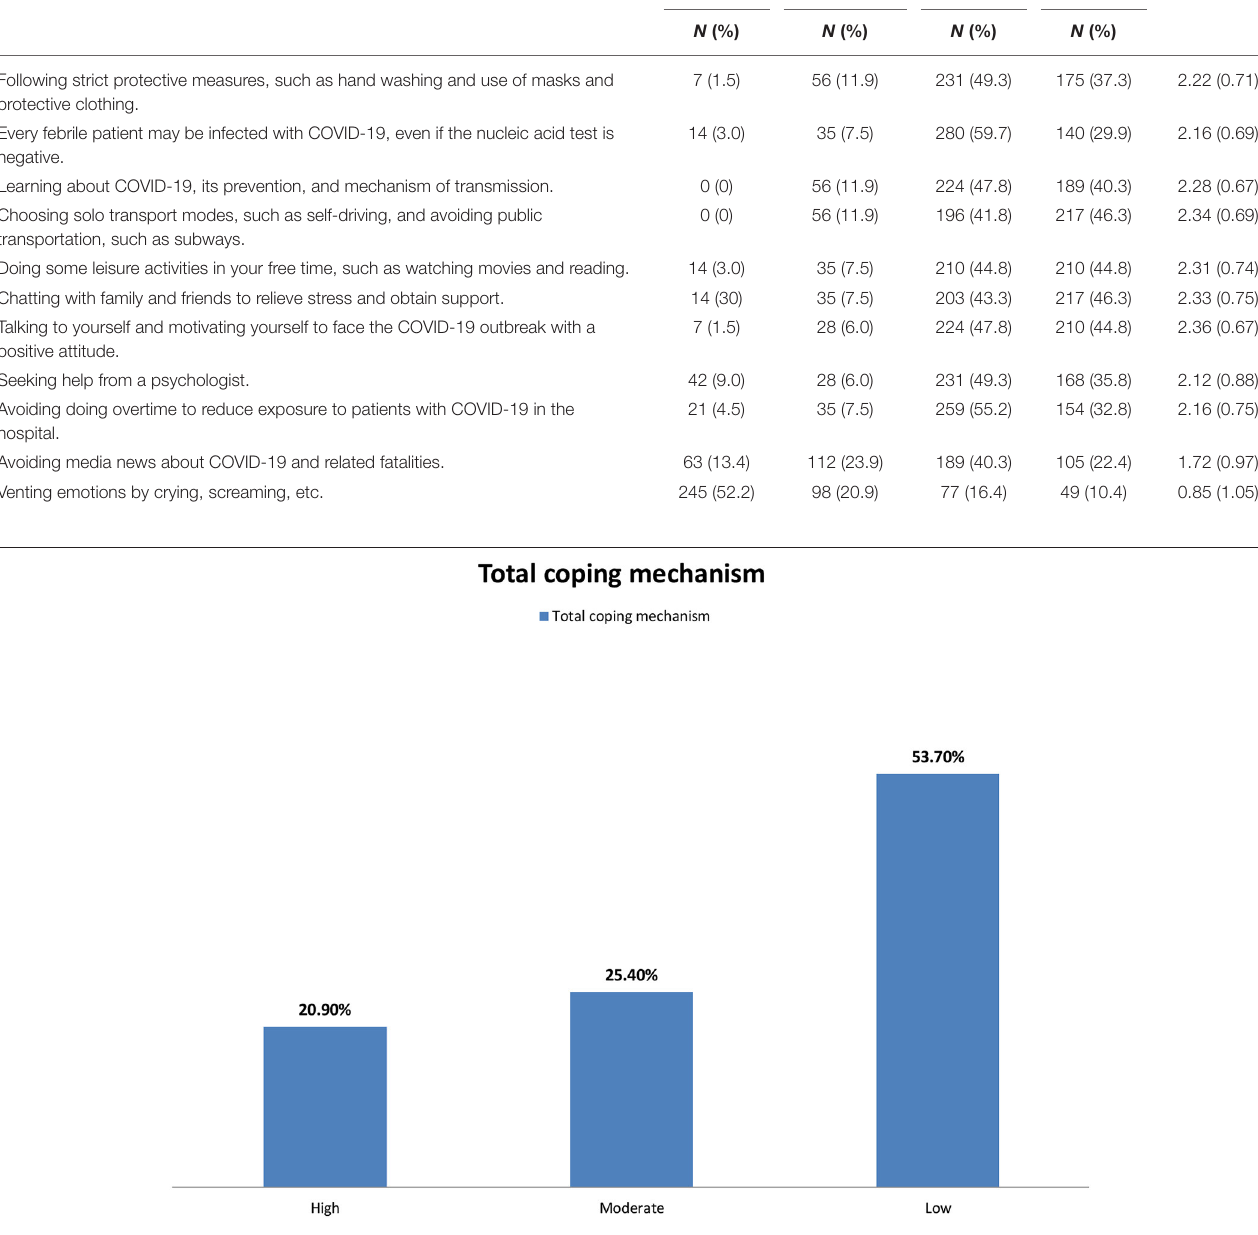
TABLE 5 | Distribution of the studied critical care nurses according to their coping mechanism ( n = 469). Items Never Sometimes Often Always Mean (SD) N (%) N (%) N (%) N (%)